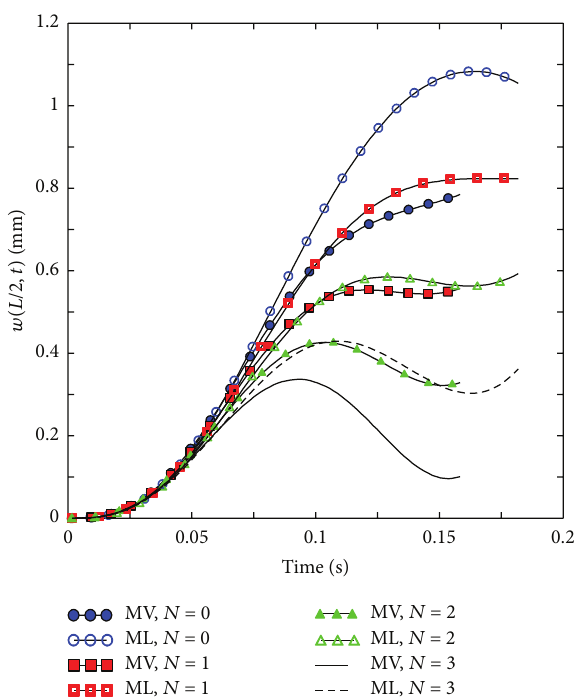
Figure 14: The dynamic response ( 𝑤(𝐿/2, 𝑡) ) for the beam with 𝜁 = 0.15 , attached to many absorbers for moving vehicle (MV) and moving load